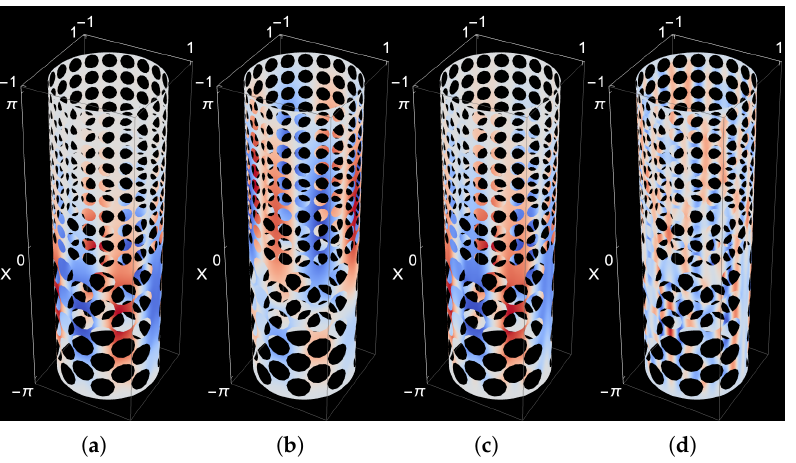
Figure 1. Trommel screen. Shell of revolution generated by a profile function φ ( x ) = 1. Transverse deflection fields under angular excitation of wave number = 20. Effect of the deterministic param- eters t (thickness) and f (frequency) is illustrated, ( a ) t = 1/100, f = 5, ( b ) t = 1/100, f = 40, ( c ) t = 1/1000, f = 5, ( d ) t = 1/1000, f = 40. Notice how, from ( a ) to ( b ), the maximal intensity moves from the area of the large perforations to the small ones, but from ( c ) to ( d ), the same effect does not take place. In ( d ), the solution is locally dominant and the energy is concentrated on the boundary